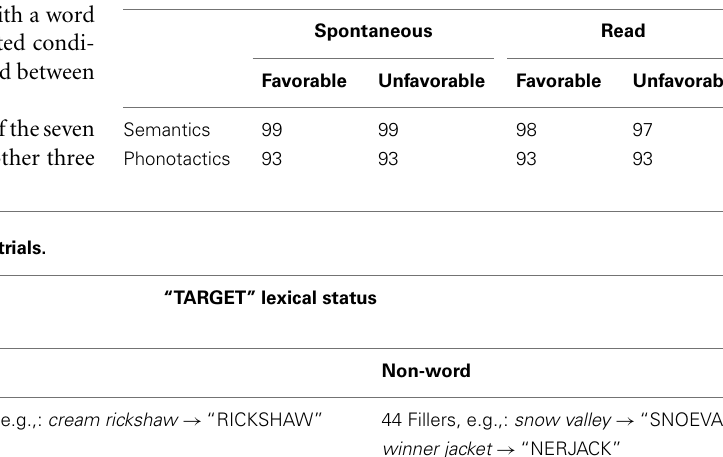
Table 4 | Proportion of correct lexical decisions (%) by condition.